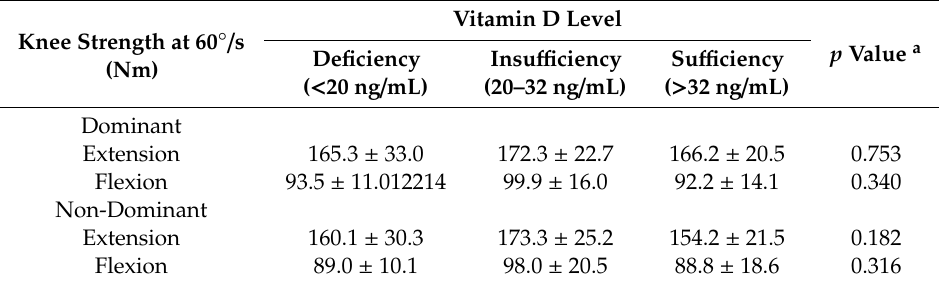
Table 3. Comparison of maximal isokinetic knee strength by vitamin D level.